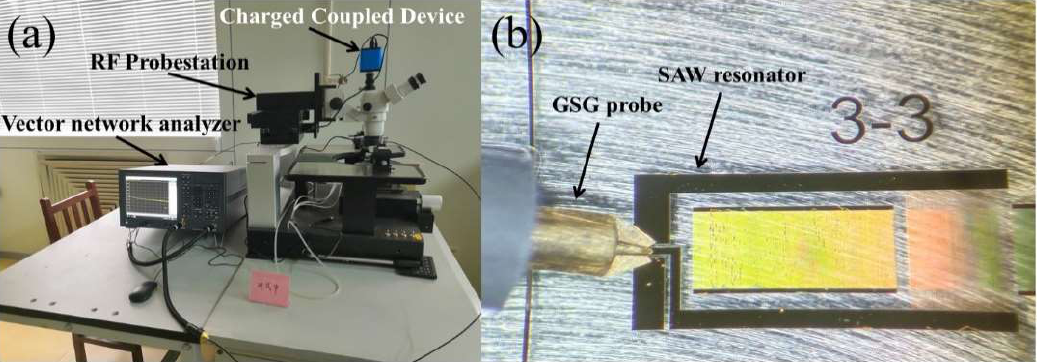
Figure 3. ( a ) Photo of the testing platform, ( a ) RF Probe station connected to Agilent E5071C vector network analyzer, ( b ) GSG probe with SAW resonator.